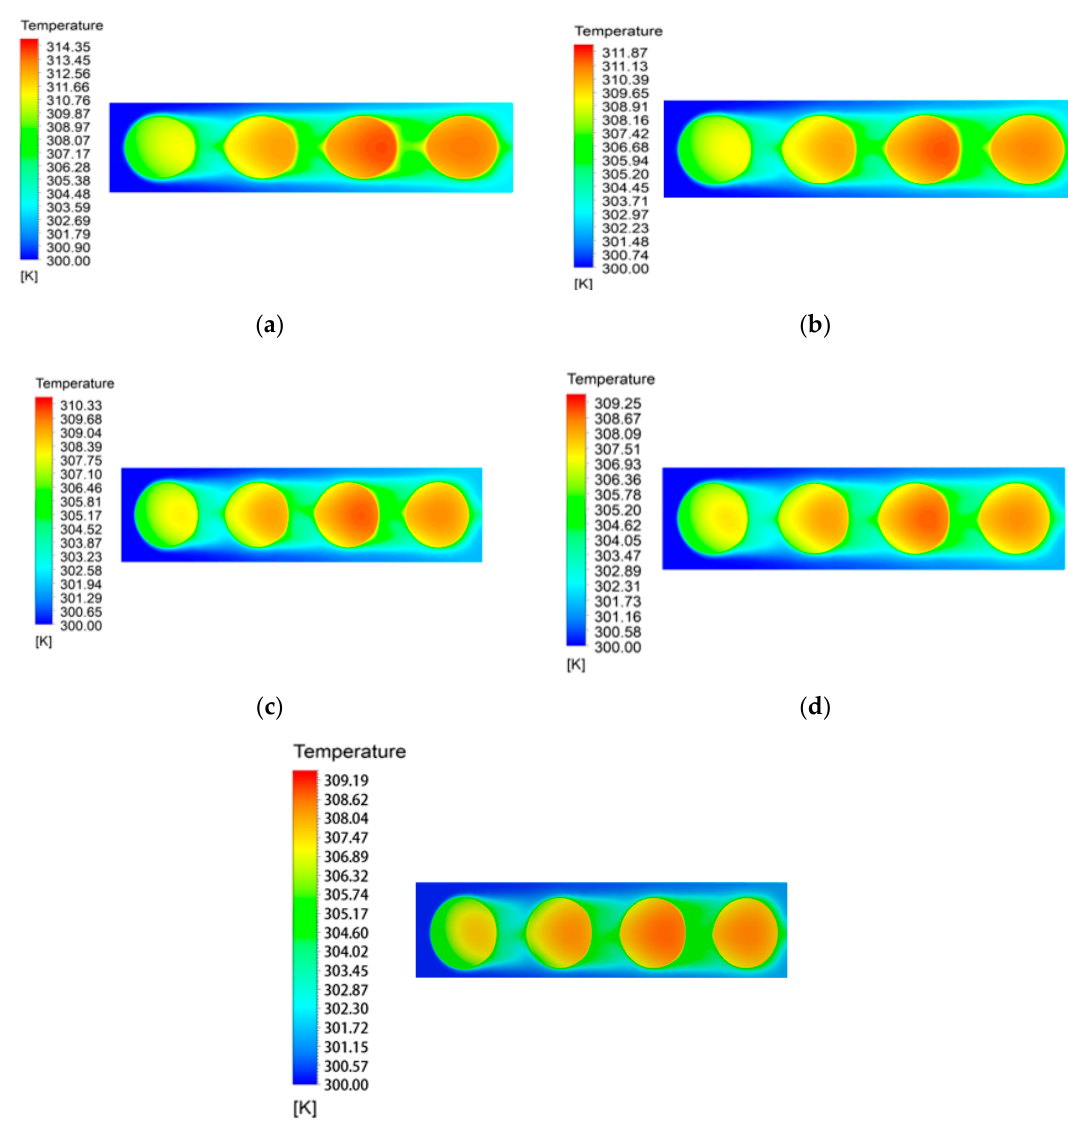
Figure 6. The temperature distribution of the middle section at different inlet velocities: ( a ) 1 ms − 1 ; ( b ) 1.5 ms − 1 ; ( c ) 2 ms − 1 ; ( d ) 2.5 ms − 1 ; ( e ) 3.0 m − 1 .